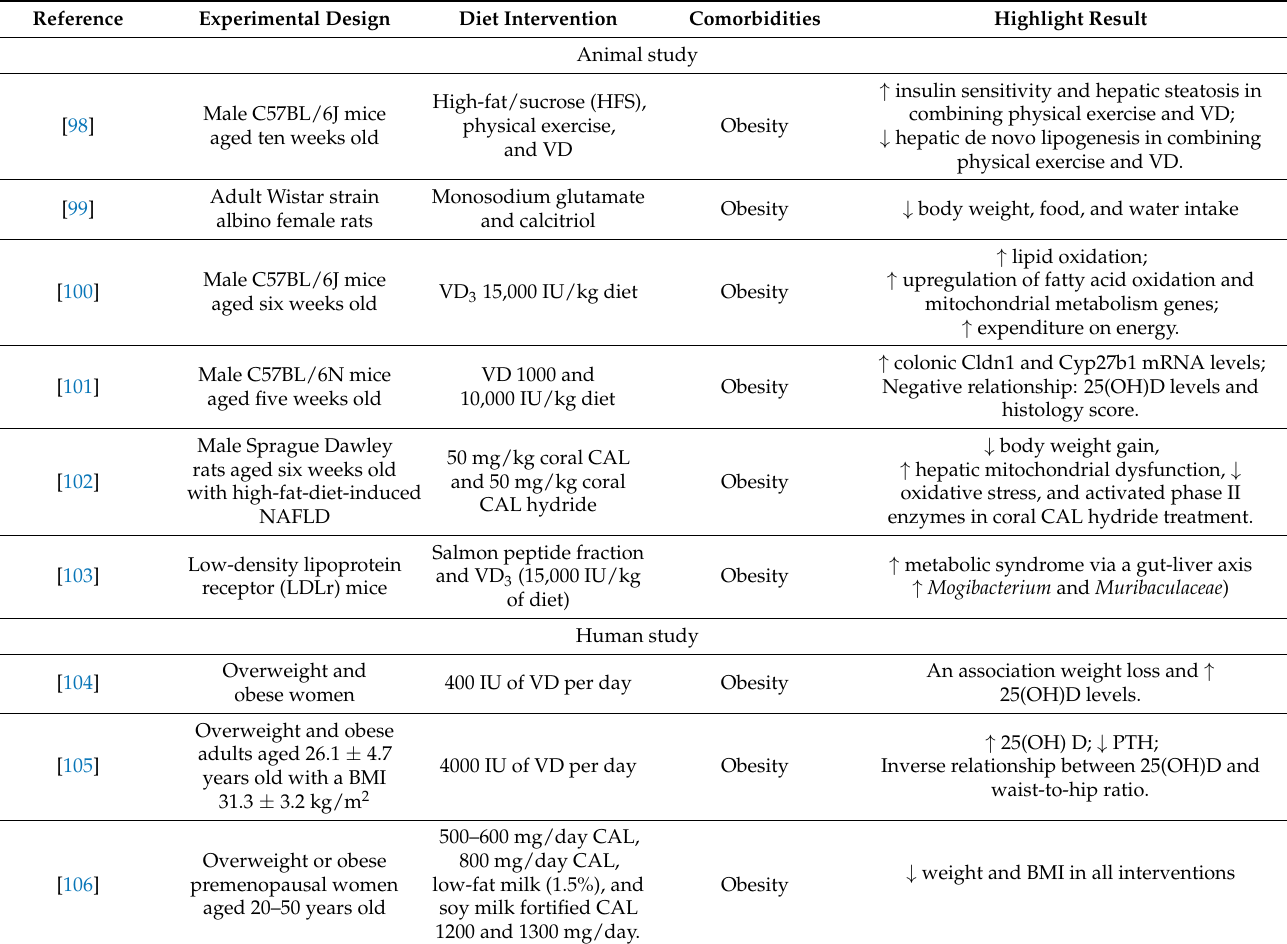
Table 6. The evidence of VD–CAL supplementation in